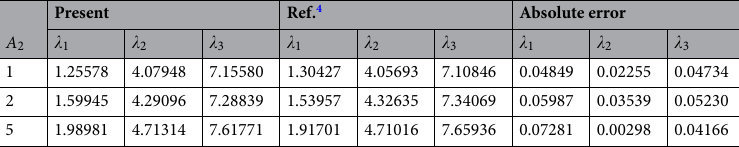
Table 2. Comparisons of present roots (cid:31) 1 , (cid:31) 2 , and (cid:31) 3 of Eq. (36) and the corresponding results in Ref. 4 using A Eqs. (47) ( 1 2 < 10 ). ≤